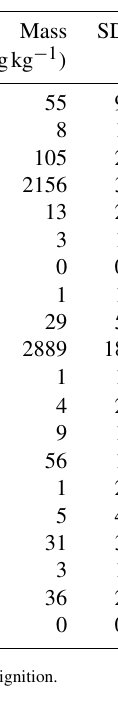
Table 1. Geochemical composition of source dunite, derived from XRF runs ( n =